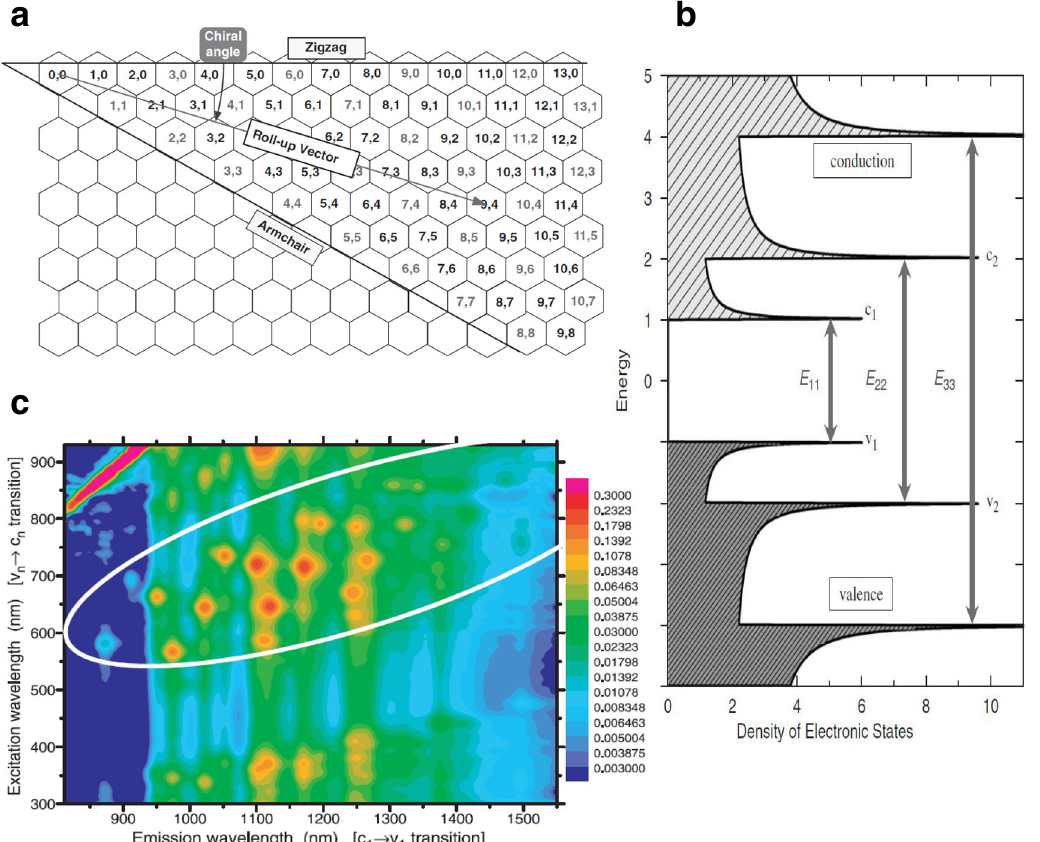
Fig. 6 Properties of SWNTs. a Schematic illustrating the roll-up vector and chiral angle combinations informing SWNT chirality. b Band diagram illustrating the electronic transitions leading to SWNT fl uorescence. Electrons are excited from v 2 into c 2 , where they relax into c 1 . Upon recombination with a hole in v 1 , photons are emitted with an energy corresponding to the bandgap. a , b Reprinted from ref. 98 with permission. c Excitation-emission maps of individually dispersed SWNTS, with excitation wavelengths ranging between 500 – 900 nm and emission wavelength of 800 – 1600 nm. Reprinted from ref. 97 with